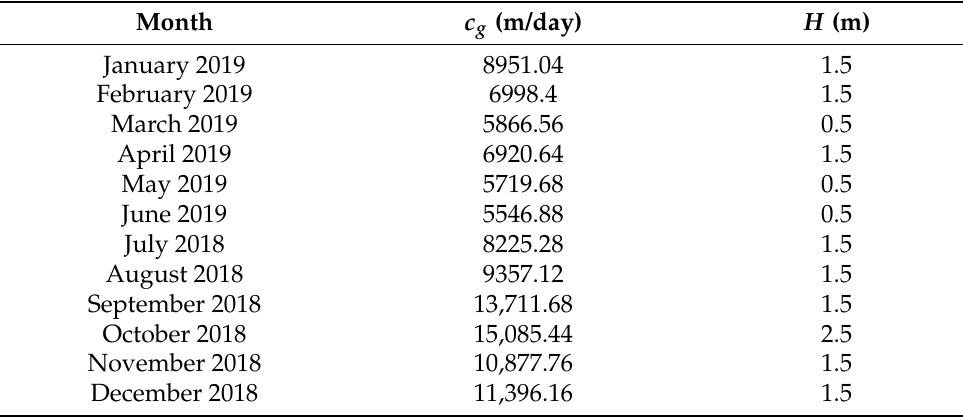
Table 2. The wave group velocity and the wave